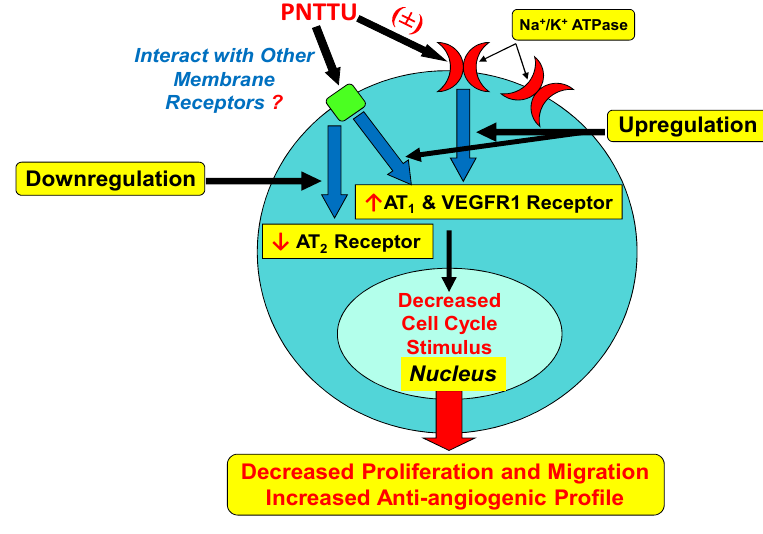
Figure 5. Diagram showing the interactions of the thiourea functional groups in the synthetic receptor PNTTU with membrane receptors via residual carboxyl groups resulting in the decrease of signaling for proliferative and angiogenic